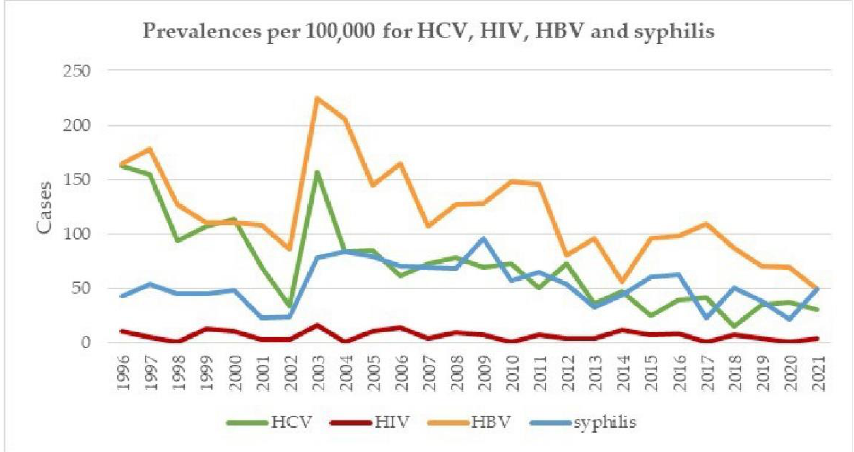
Figure 4. HCV, HBV, HIV and syphilis prevalences per 100,000 FD from 1996 – 2021.